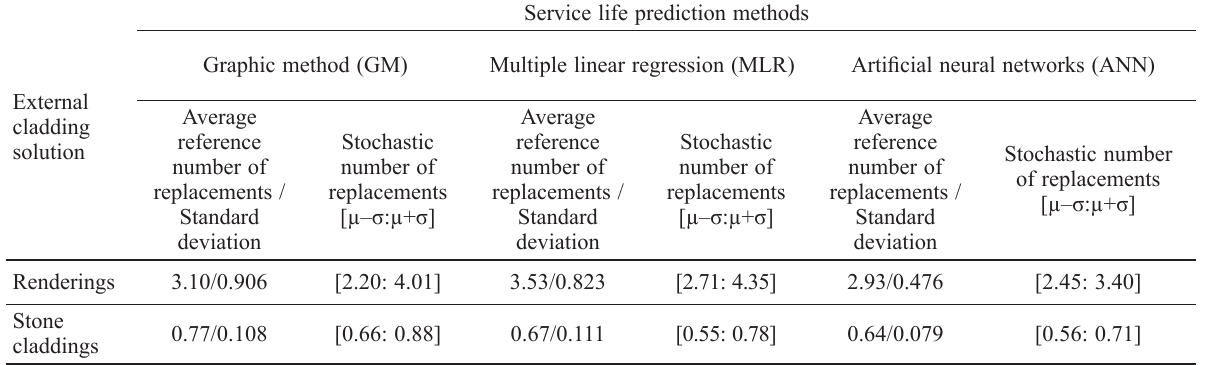
table 5. reference and stochastic number of replacements over a 50-year period (considering that the number of replacements follows a Normal distribution)